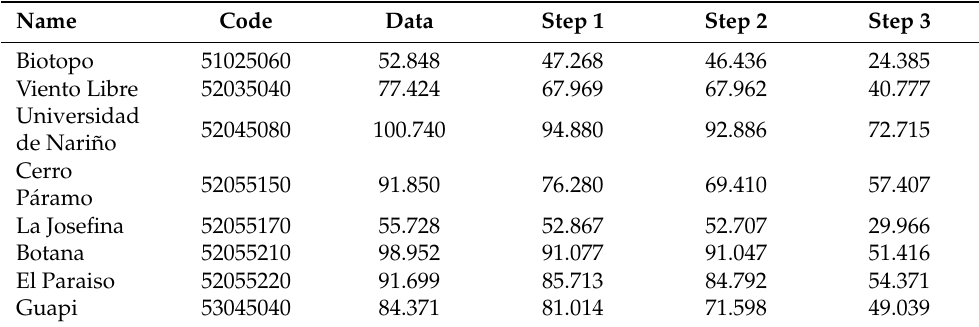
Table 9. Temperature validation results. Each step presents the amount of data that overcome the validation